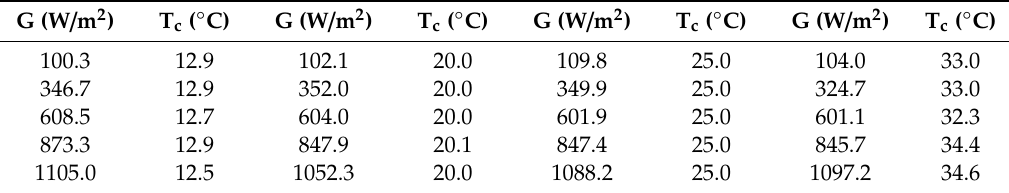
Table 1. Irradiance ( G ) and ambient temperature ( T C ) of the PV module for training MLP to obtain I-V curves.